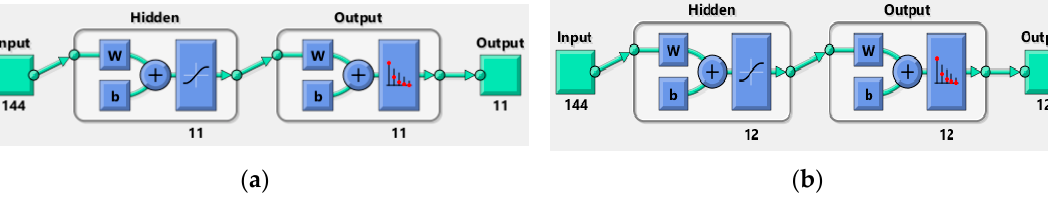
Figure 2. Neural network architecture for both scenarios listed as: ( a ) artificial neural network (ANN) training model for fault detection and classification for the balanced load scenario (11 outputs = 10 fault types + 1 non-fault case), and ( b ) ANN training model for fault detection and classification for the unbalanced scenario (12 outputs = 11 fault types + 1 non-fault case). Appl. Sci. 2020 , 10 , x FOR PEER REVIEW